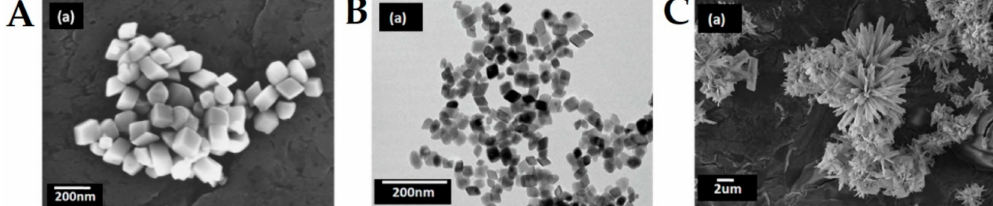
Figure 4. ( A ) SEM image of distorted cubes. ( B ) TEM image of nanocubes. ( C ) SEM image of self-oriented flowers. Reproduced from [115] with permission from Springer Nature,